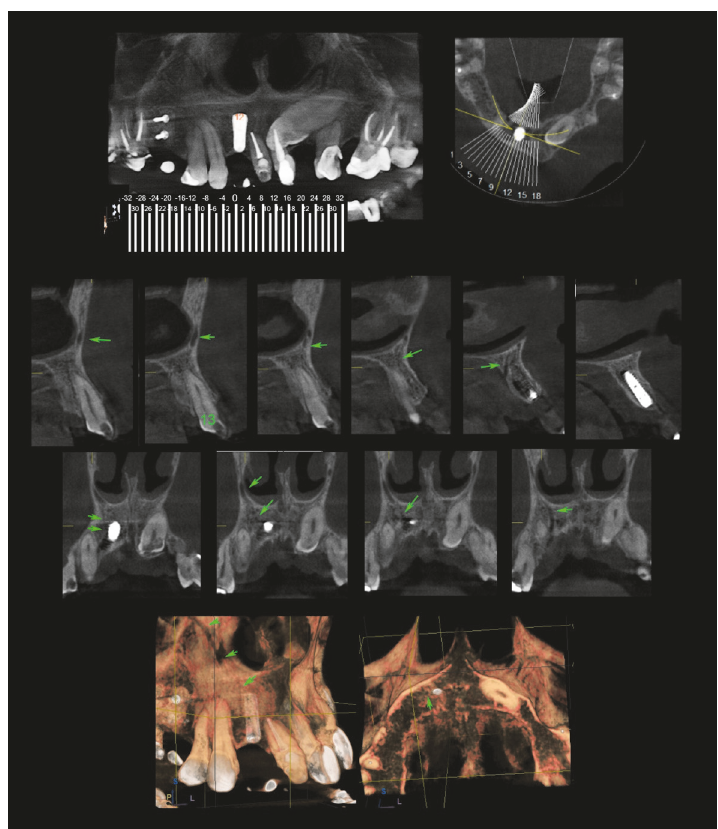
Figure 1: Transaxial reconstructions: hypodense course measuring about 2.0 mm wide adjacent to the top of the implant and the canine apex that extends upwards and in the anterior wall of the nasal cavity (see green